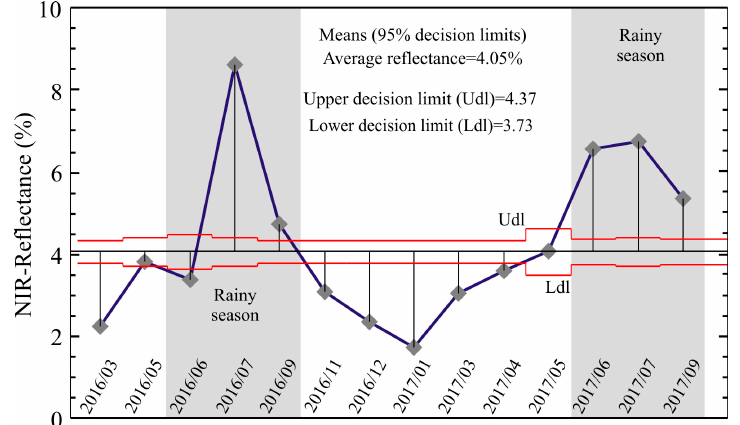
Figure 8. NIR-reflectance inter-annual variation, highlighting the seasonal contrasts between summer and winter seasons.